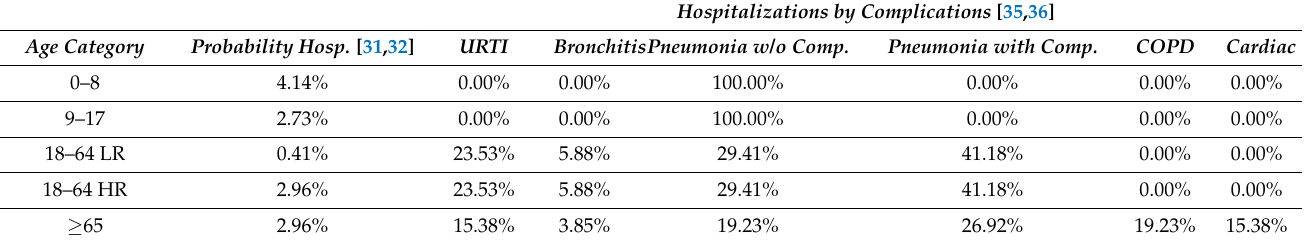
Table 8. Influenza-related